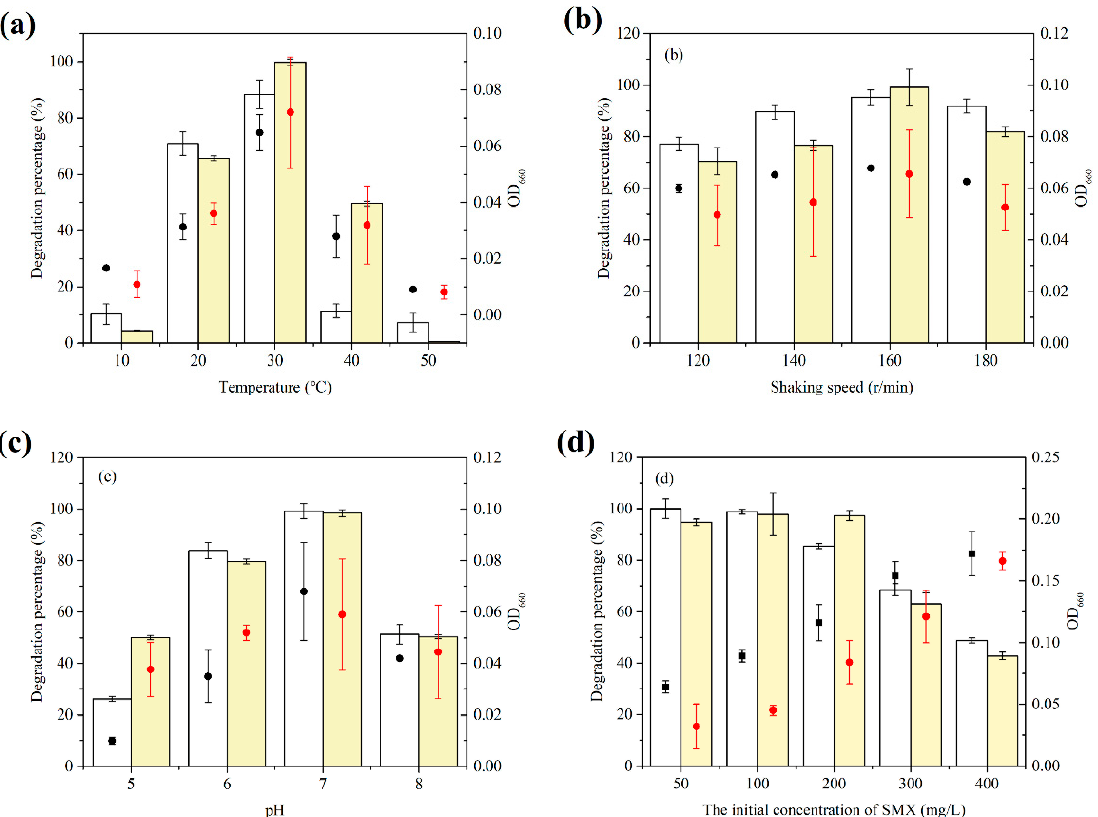
Figure 3. Effects of different conditions on the growth and degradation of the consortium with SMX as a sole carbon source. Columns represent the degradation percentage of SMX. ( a ) Effects of incubation temperature. ( b ) Effects of the rotation speed of shaking. ( c ) Effects of media pH. ( d ) Effects of the initial concentration of SMX.